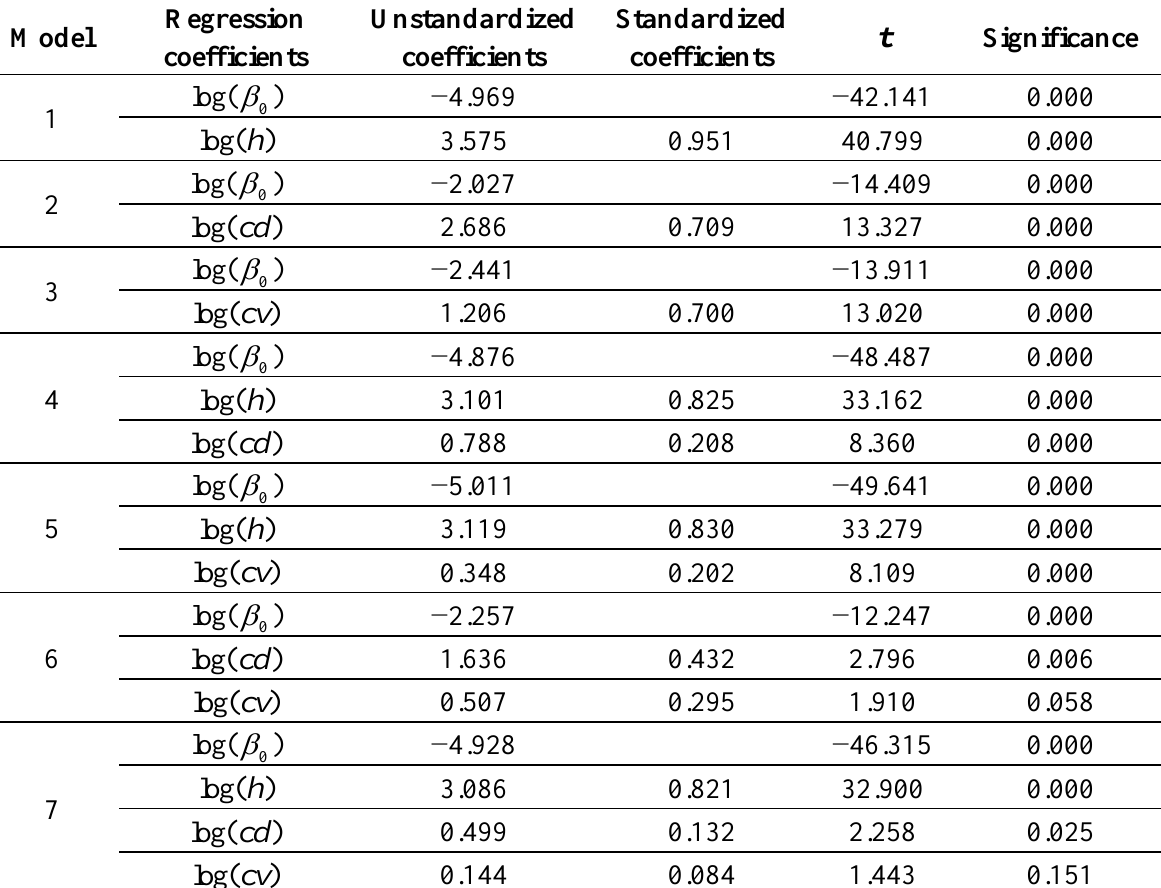
Table 8. Regression models for stem volume estimation.